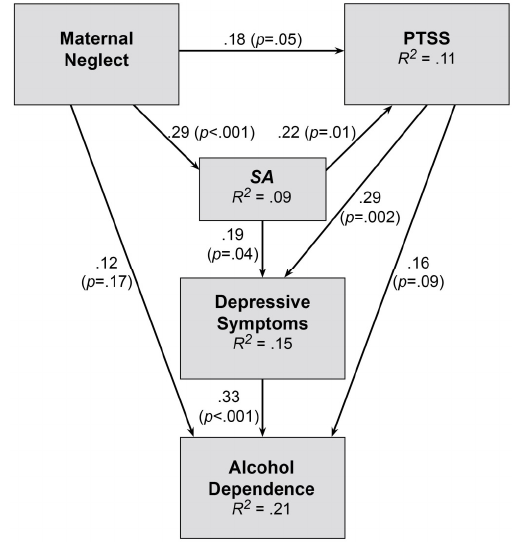
Figure 1. Sexual assault ( SA ) Path Analysis Model: Effects of SA and Maternal Neglect on symptoms of posttraumatic stress, depression and alcohol dependence.